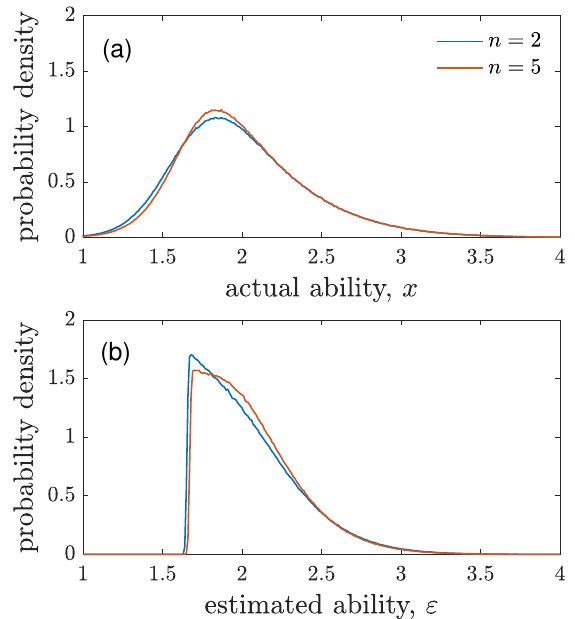
Figure 2: Distributions of actual ability (a) and estimated ability (b) for the prestige class under the dynamics of Case I, where the prior is based on accurate knowledge of the true abilities within each class. Only the distributions for n = 2 and n = 5 are shown; larger values of n practically coincide with the latter. Here the standard error of the exam w = 0.3.